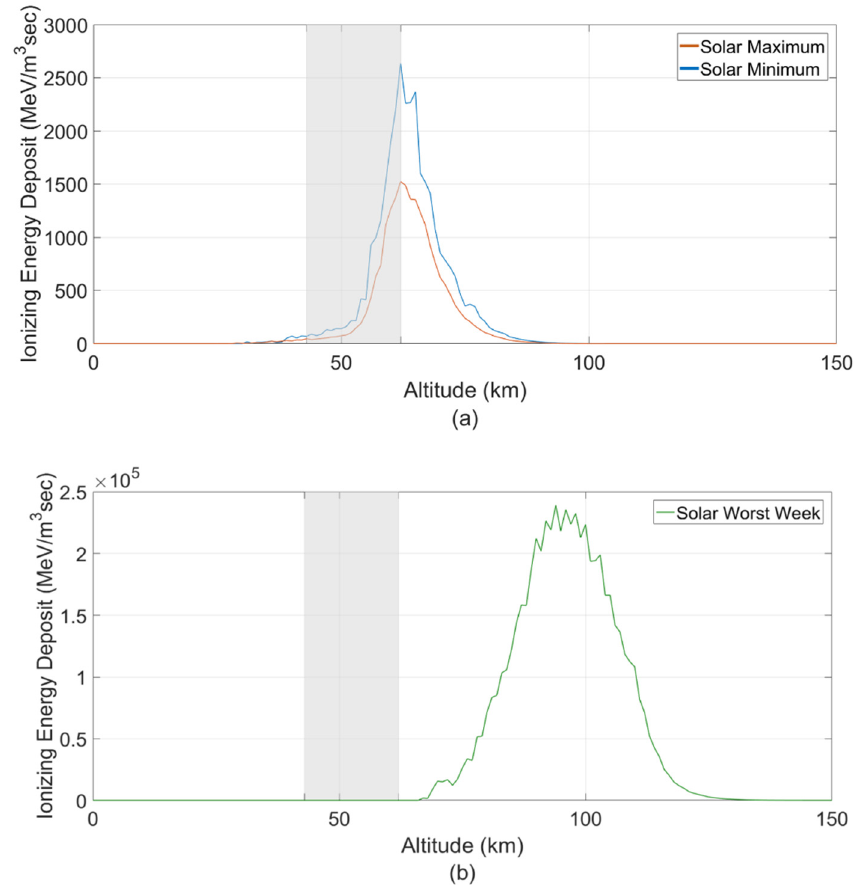
Figure 3. Energy deposition in the Venusian atmosphere for solar minimum and solar maximum conditions ( a ) and for the Worst Week scenario ( b ).